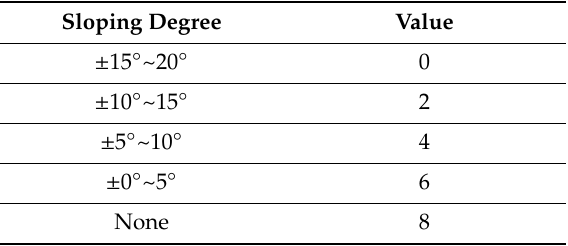
Table 5. Value for sloping degree.